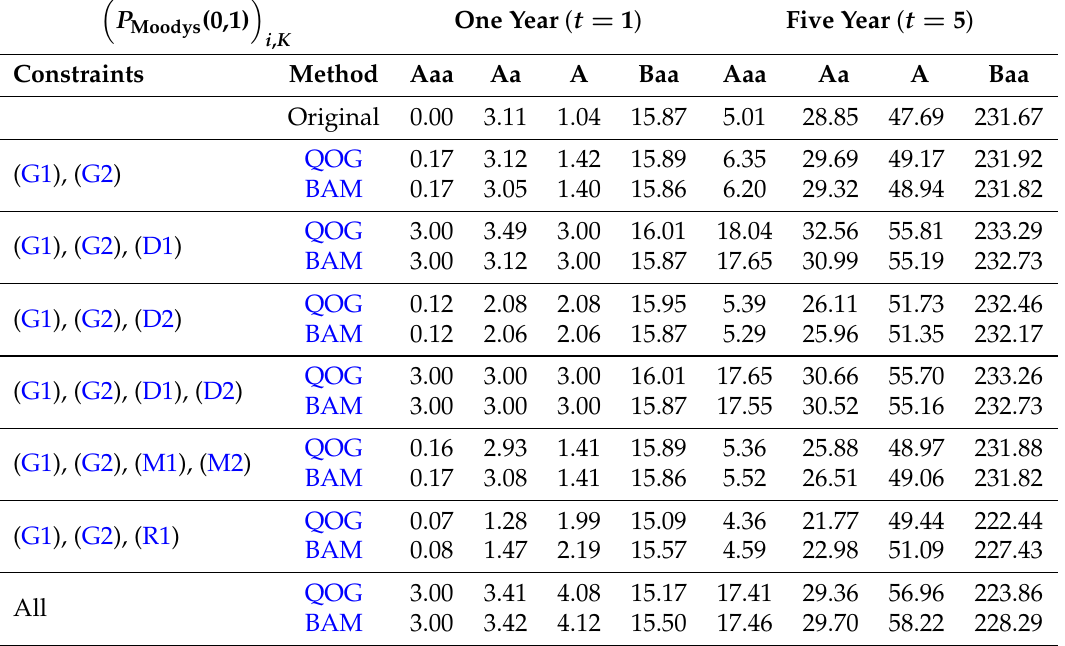
Table 4. Comparison of one- and five-year default probabilities in the basis points (bp) of QOG and BAM, for given transition matrix P Moodys ( 0,1 ) in Table A1.